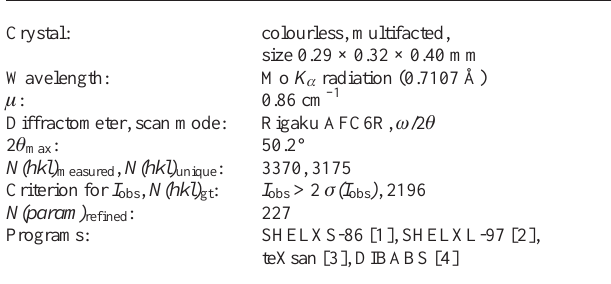
Table 1. Data collection and handling.